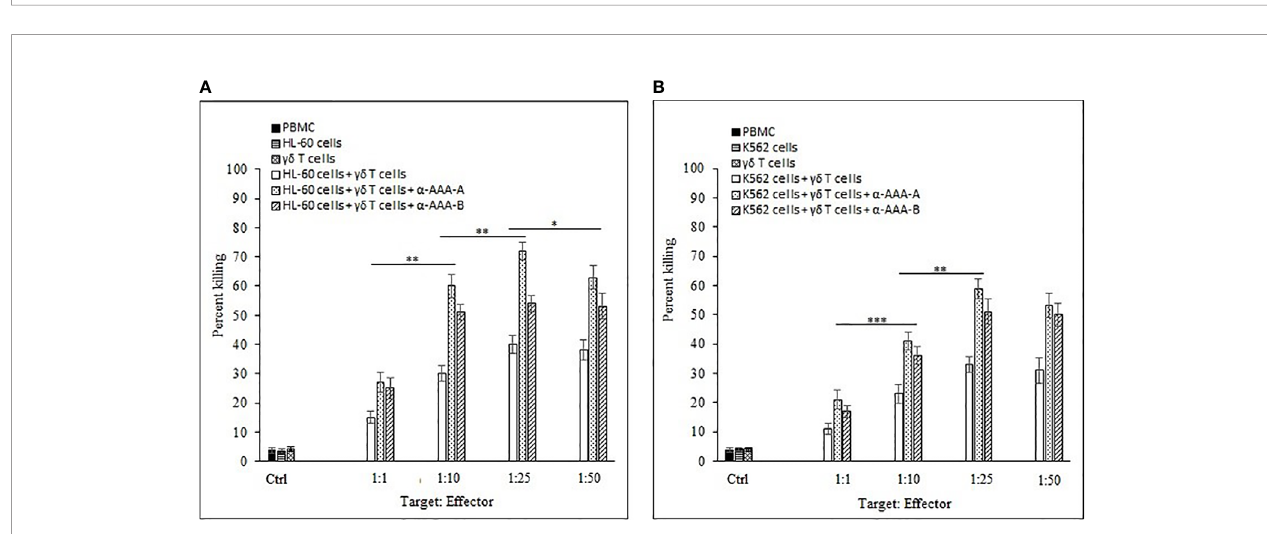
FIGURE 9 | Combinational effect of both amide analogs and expanded gd T cells. Percent killing of HL-60 (A) and K562 (B) cancer cells by 14 days expanded gd T cells in combination with a -AAA-A or a -AAA-B. Different T:E ratios were incubated together for a duration of 12 h. PBMCs alone, cancer cells alone and gd T cells alone served as controls (ctrl). For HL-60 cancer cell line (A) , the concentrations of a -AAA-A and a -AAA-B used were 3.125 and 6.26 m M, respectively. For K-562 cancer cell line (B) , concentrations of a -AAA-A and a -AAA-B used were 6.26 and 12.5 m M, respectively. Signi fi cance represented as *** P < 0.001 , ** P <0.01 and * P< 0.05.